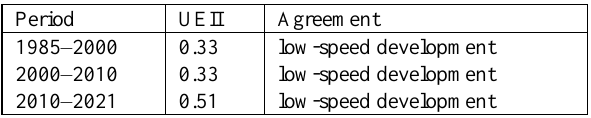
Table 5 . Values of the Urban Expansion Intensity Index